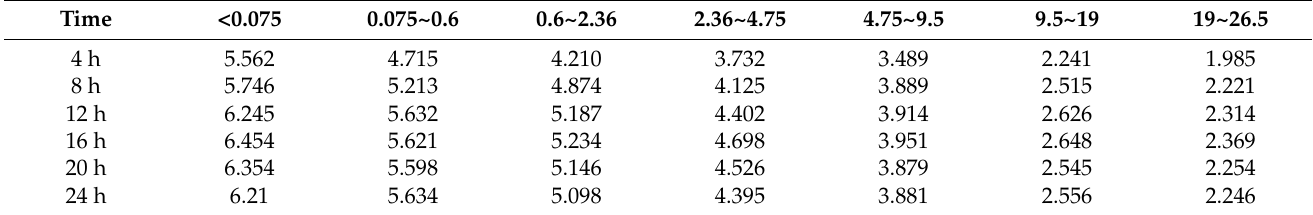
Table 6. V precipitation(mg/L).